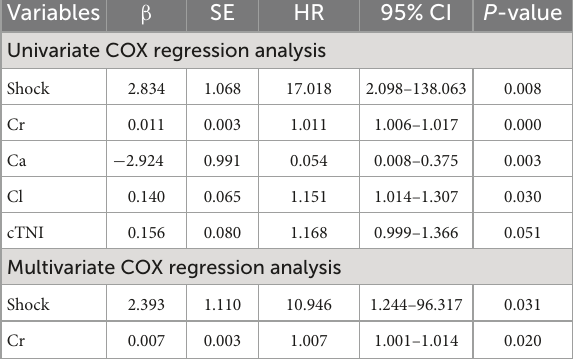
TABLE 3 Cox proportional hazards regression model analysis with multivariate regression of death of organophosphorus